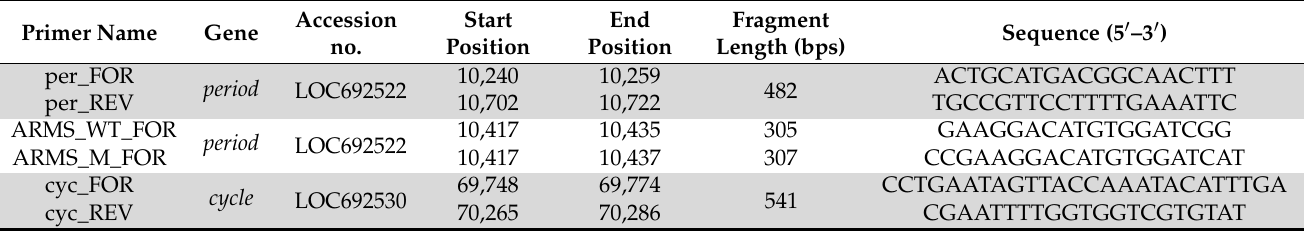
Table 1. PCR primers for standard and